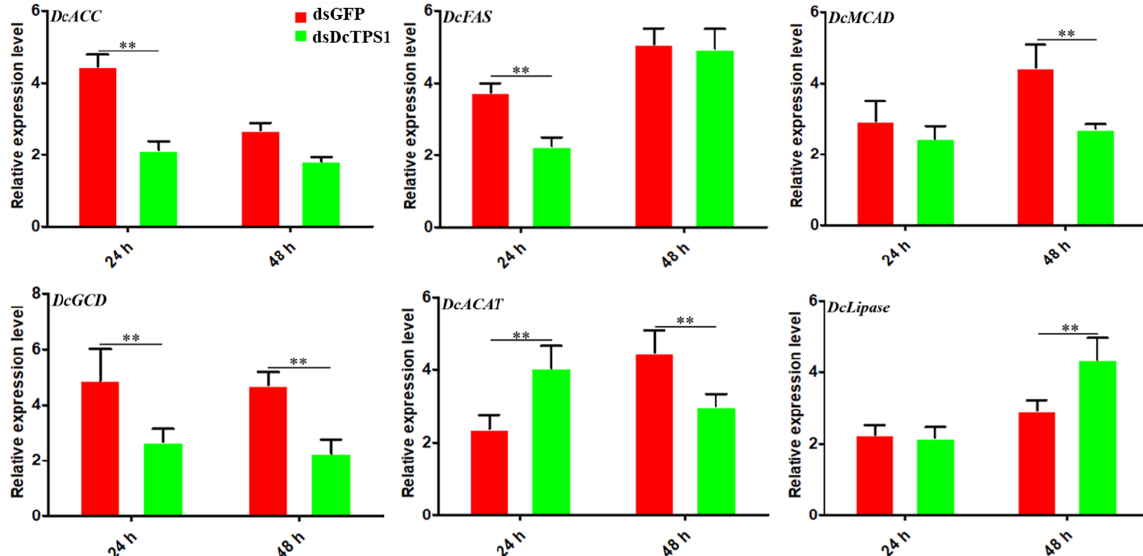
Figure 7. Effects of RNAi on key genes in Diaphorina citri fatty acid metabolism pathway. The ds GFP treatment group was used as a control. The mean expression level represents three biological replicates. The asterisks indicate significance differences by ** p < 0.01. The SPSS software was used to conduct statistical analysis.